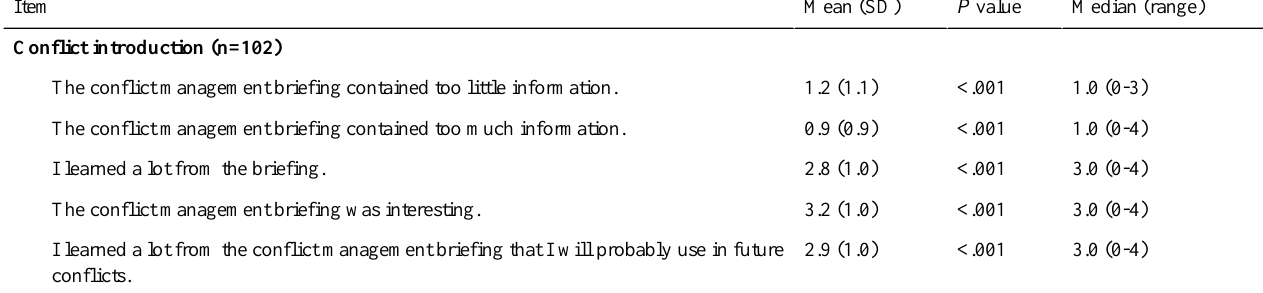
Median (range) P valueMean